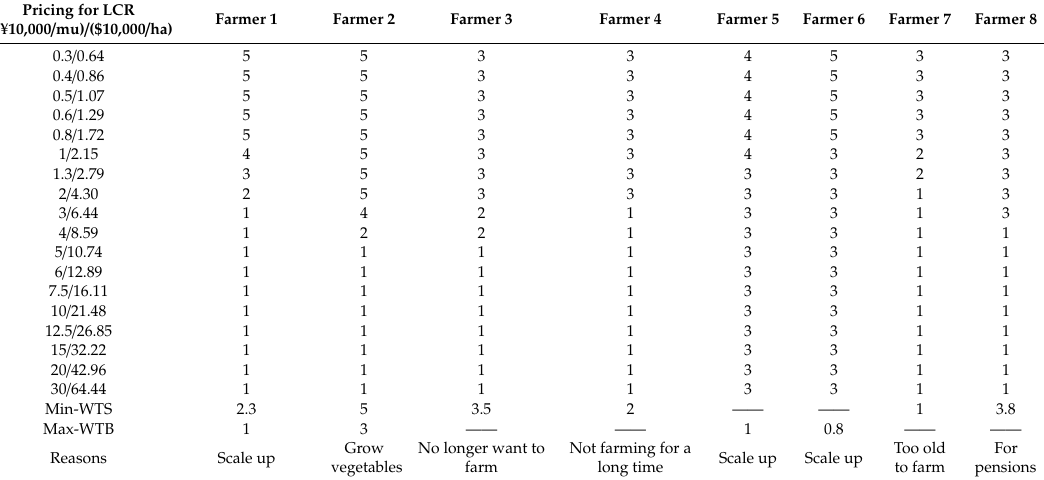
Table A1. Examples of 8 farmers’ pricing selections for 18